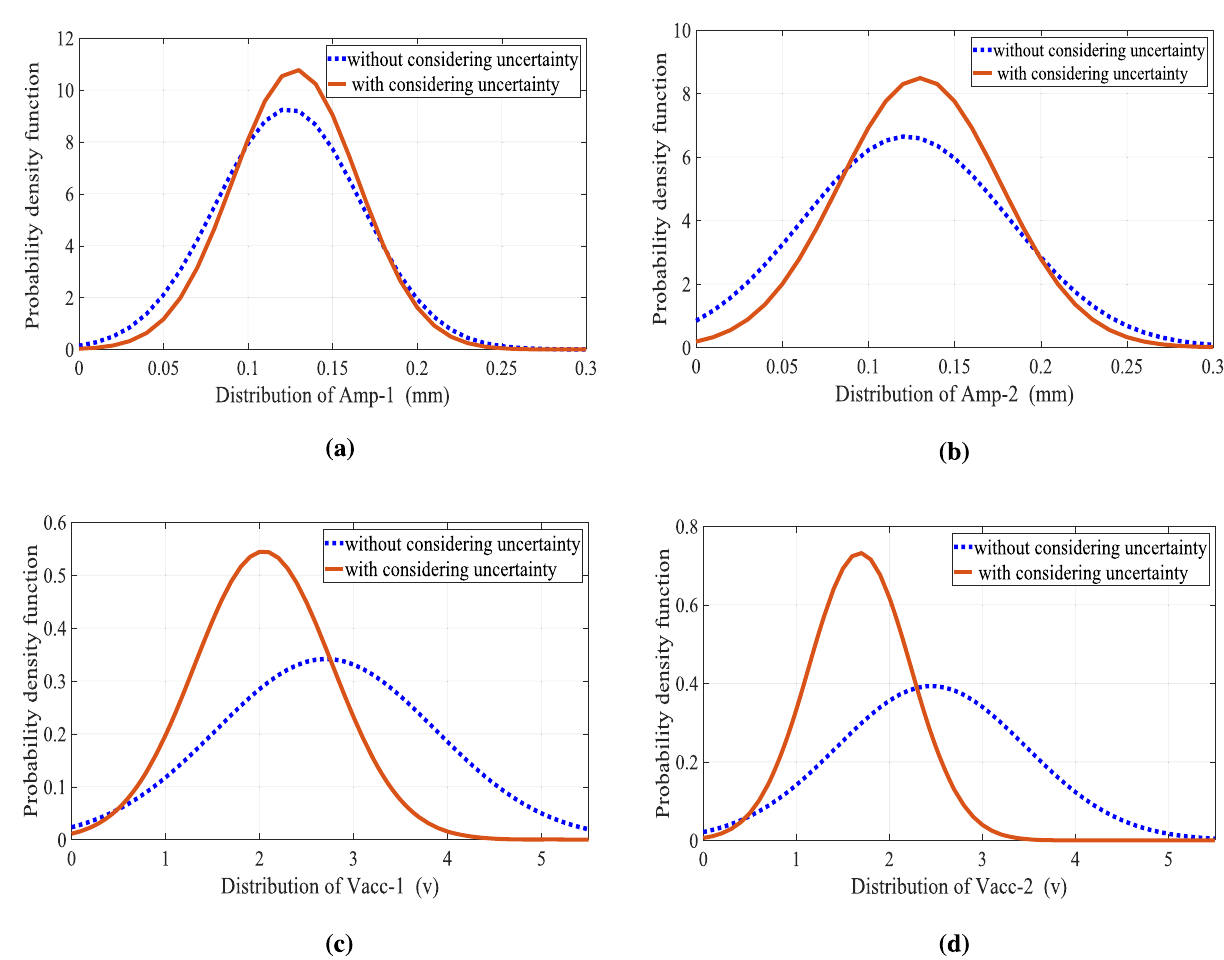
Fig. 5. Distribution comparison of the response values with or without considering the uncertainties. (a) Amplitude response of disk1. (b) Amplitude response of disk2. (c) Acceleration response on bearing1. (d) Acceleration response on